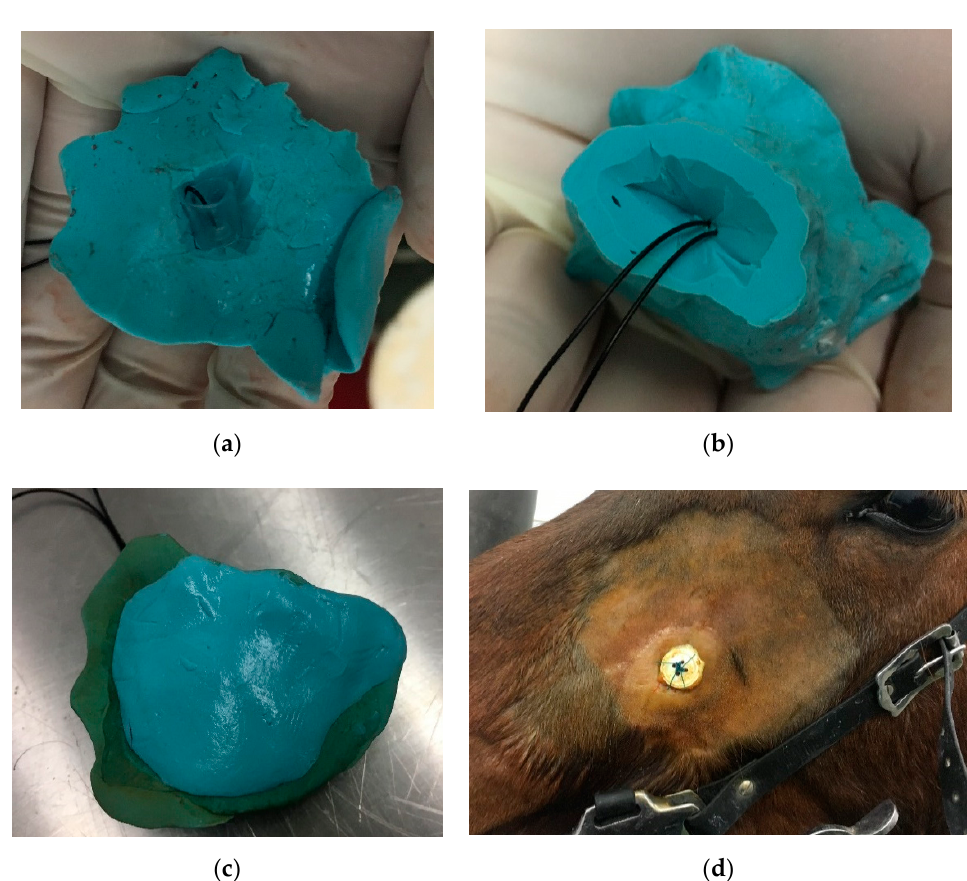
Figure 8. Polyvinyl siloxane impression material inserted into newly created oro-nasal fistula fastened with thread and button: ( a ) occlusal surface, ( b ) alveolar surface, ( c ) sealed occlusal surface, ( d ) button at the skin surface.